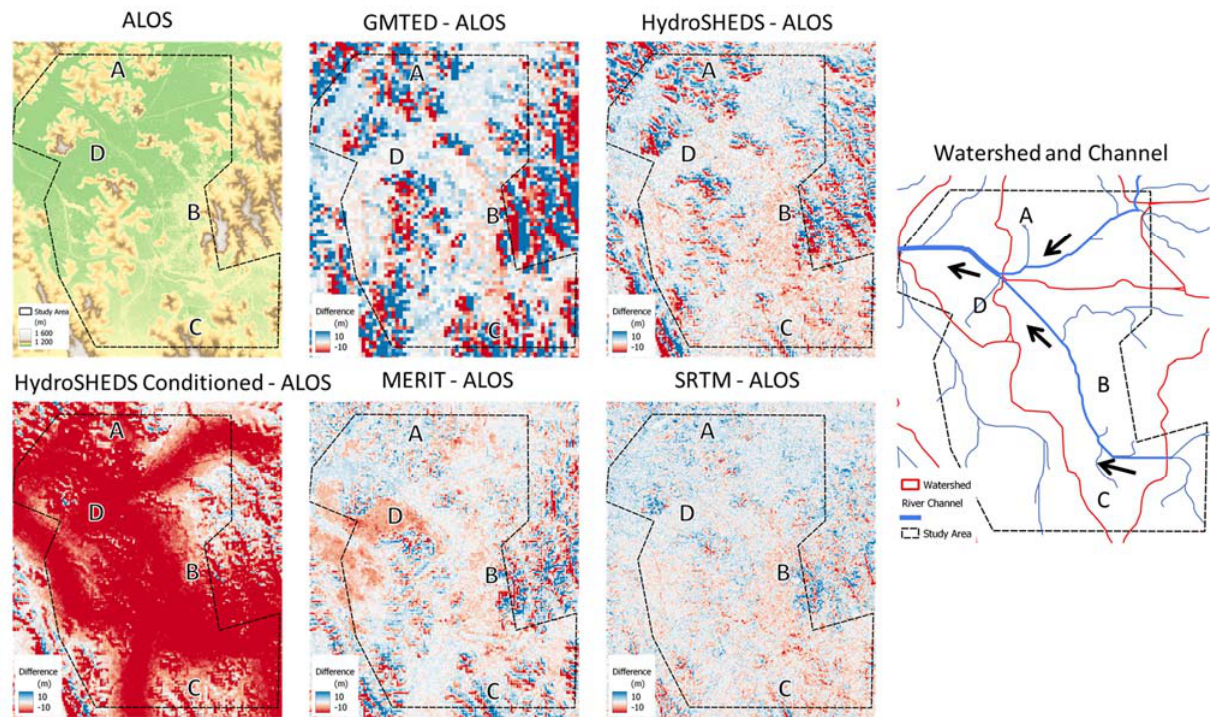
Figure 8. ALOS DEM, its differences with other DEM datasets, and the study area’s watershed and channel flow map.